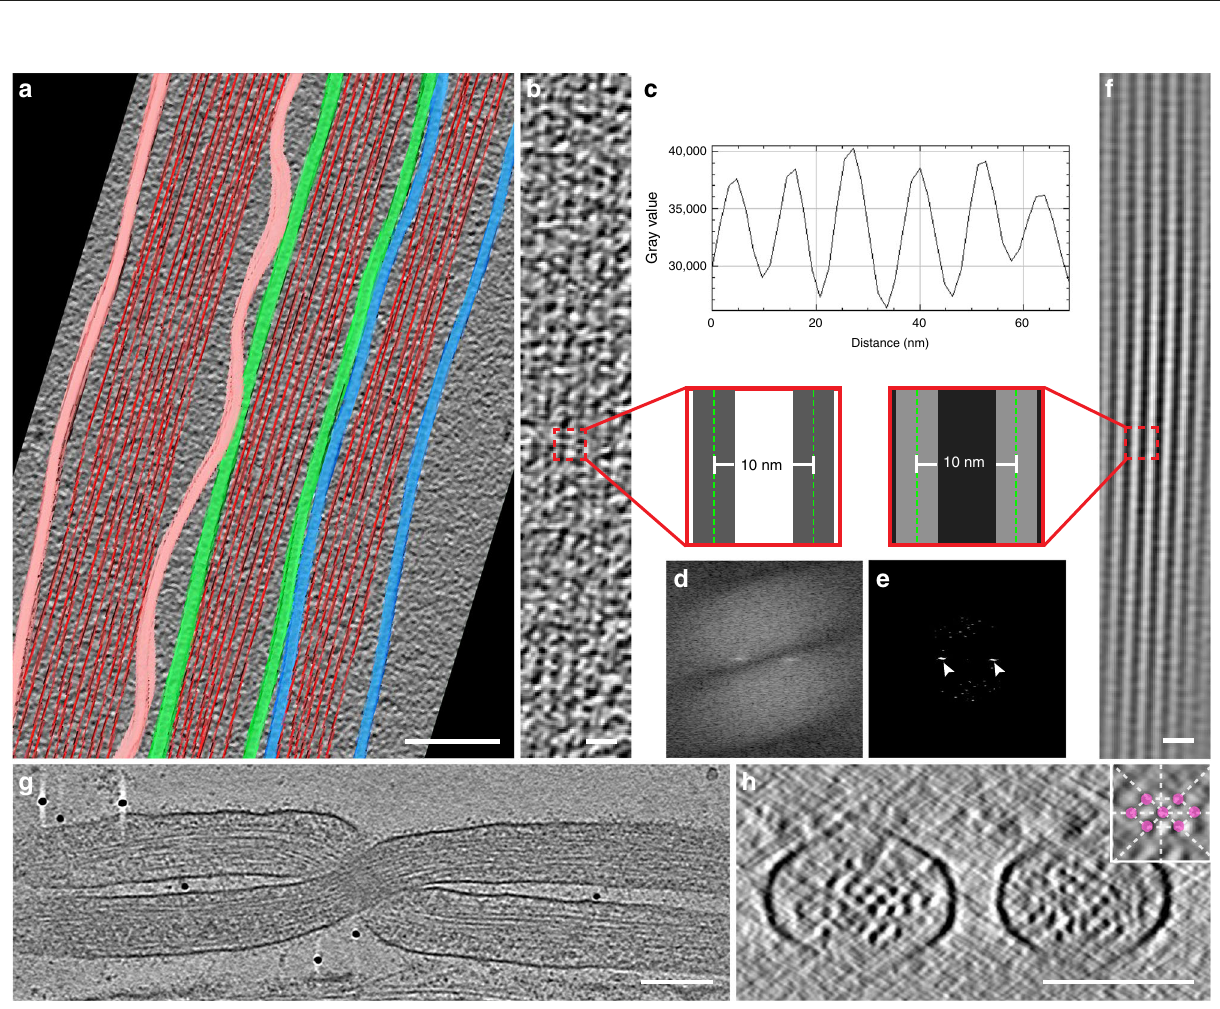
Fig. 4 Cryo-electron tomography reveal F-actin organization in iTNTs. a Segmentation rendering obtained from a tomogram showing iTNTs (Supplementary Movie 8). The average size and spacing between fi laments of an iTNT shown in b were measured by computing the plot pro fi le of actin bundles residing within. c – e Filament-to- fi lament distance measured by extracting peaks in the frequency domain using the fast Fourier transform (white arrowheads, e ) and by computing plot pro fi les ( c ). f Model of the actin fi laments displaying a parallel bundle in iTNTs obtained by retransforming peaks in the frequency domain shown in e . Insets in b and f show distances between the average measurements in nm obtained by the analysis shown in c and d . g High-magni fi cation cryo-tomogram slice of two iTNTs (Fig. 3b and Supplementary Movie 4). h Cross-section of the cryo-electron tomogram in g displaying the actin arrangement within two iTNTs. Scale bars: a , 100 nm; b , f , 20 nm; g , h , 100